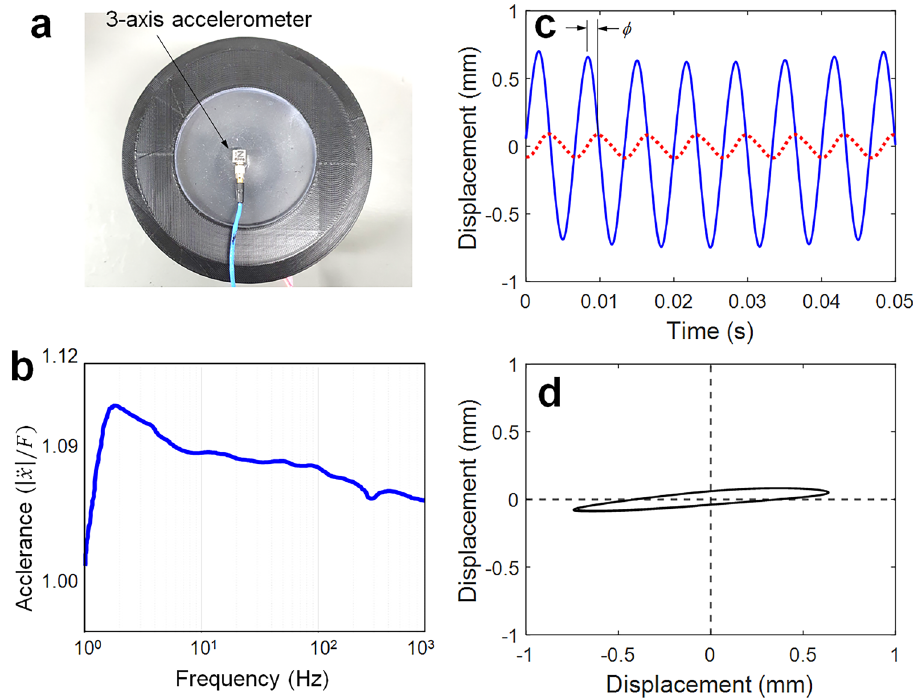
Figure 5. Vibration responses to sinusoidal excitation measured by an in-situ 3-axis accelerometer: ( a ) photograph of 3-axis accelerometer, ( b ) frequency response function (accelerance, |¨ x | responses to the frequency of 150 Hz: blue line: z -direction, red dotted line: y -direction, ( d ) its Lissajous